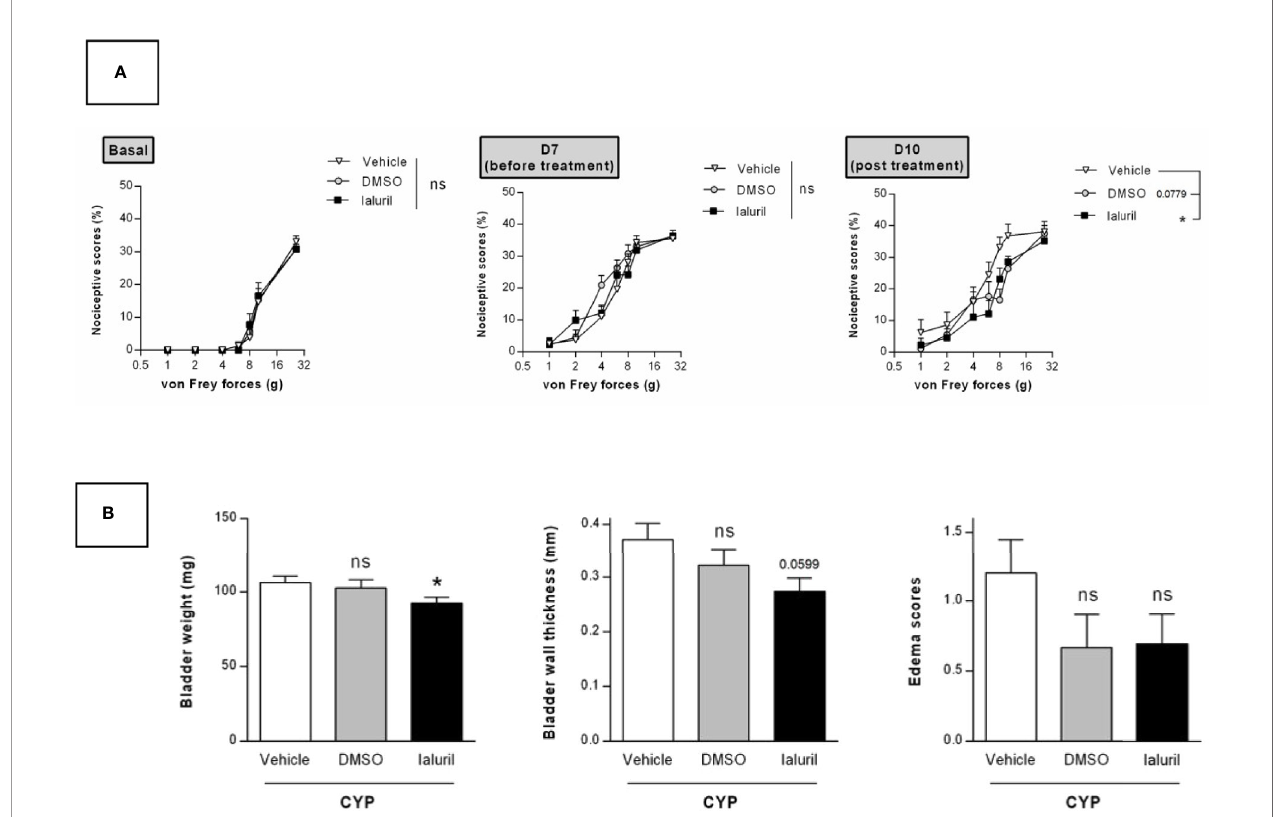
FIGURE 7 | Validation of the model by curative intravesical treatment of clinically relevant compounds. Rats were treated with either DMSO (50%, i.ves.), Ialuril ® (i.ves.) or saline vehicle (500 µl/rat, i.ves.) on day 7. (A) Nociceptive response was assessed at day 7, once the cystitis was established but before start of the pharmacological treatment (Before) and at day 10 (Post). Nociceptive score was expressed as the percentage of the maximal score for each von Frey force. (B) Bladder in fl ammation was assessed at day 10 by measuring bladder weight, wall thickness and edema scores. Data represent mean values ± SEM (n = 10 for Vehicle and Ialuril ® and n = 9 for DMSO). ns p > 0.05, *p < 0.05 (A) two-way RM ANOVA; (B) Mann Whitney or unpaired t